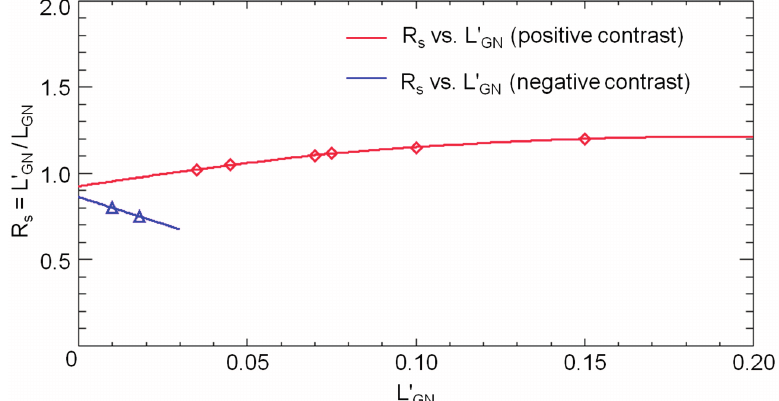
Figure 6. Oil spill index R s as a function of L' GN for the seven scenes of the training dataset (Tables 1 and 3). The red and blue curves are the cubic spline and linear interpolation, respectively, between R s values. The red (blue) curve represents the lower (upper) R limit for oil spill detection in positive (negative) contrast